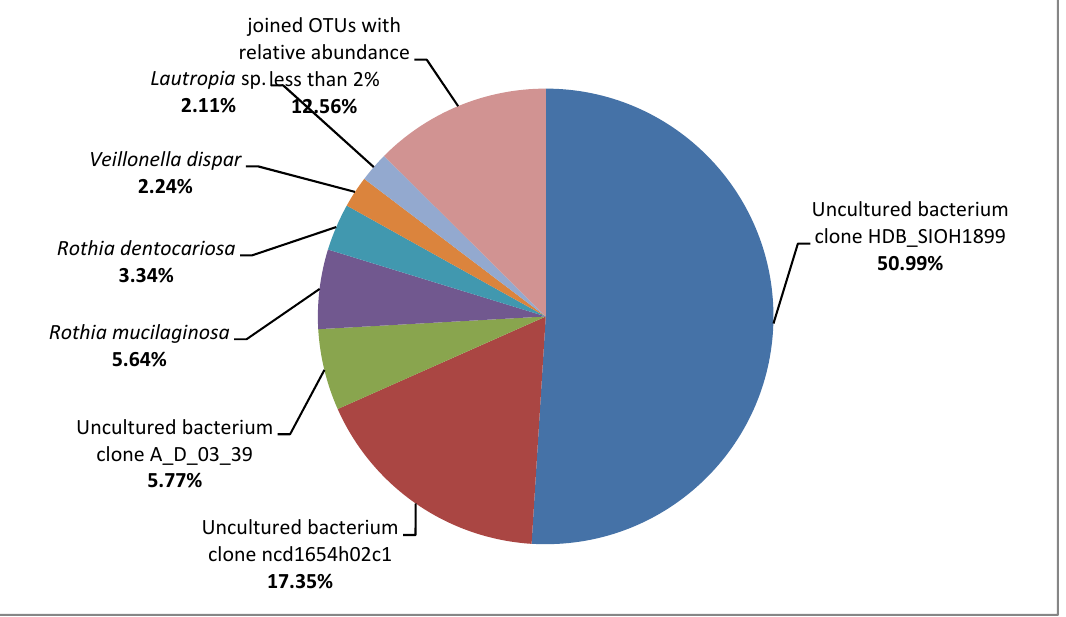
Figure 2. Identification results of the bacteria isolated from the composite surfaces, using the NGS method.